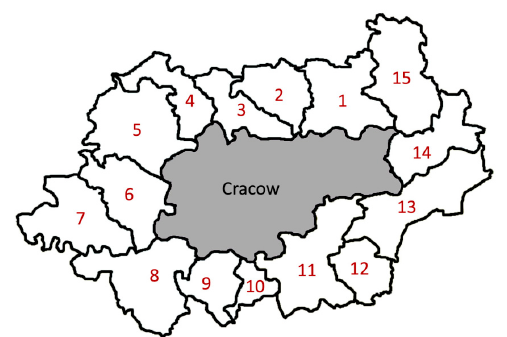
Figure 10. Municipalities adjacent to Cracow, which are the closest vicinity of the city. (Source: own